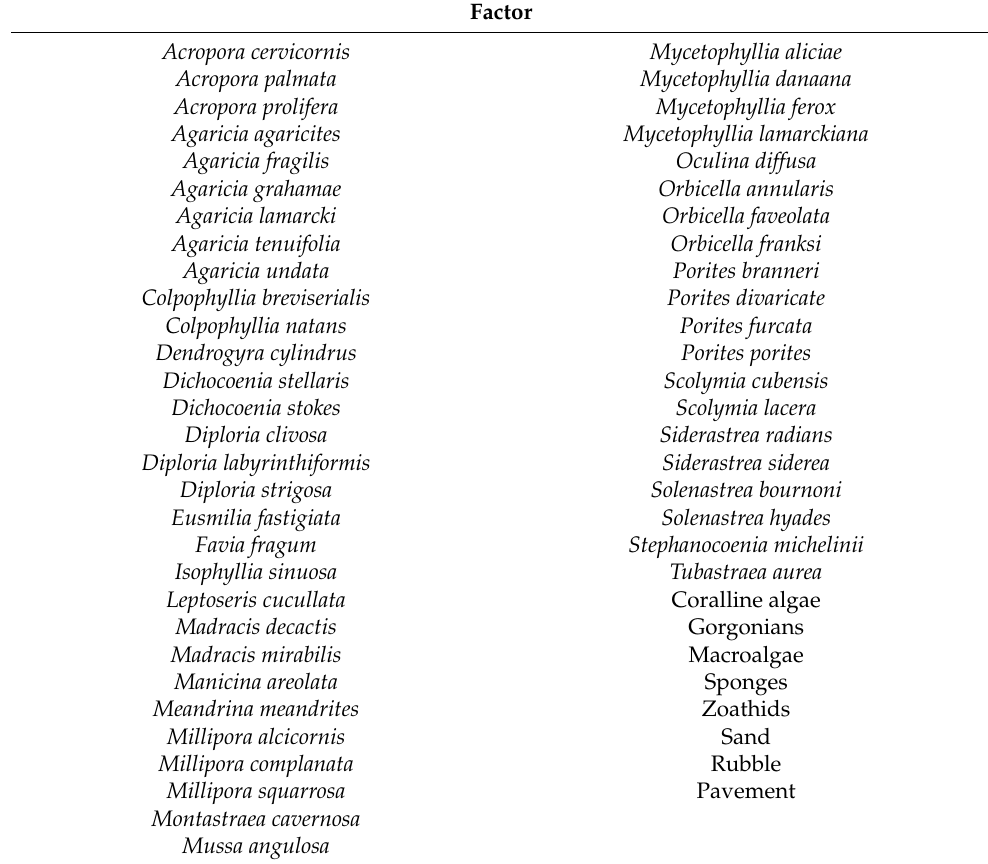
Table 2. Interspecific and substrate factors tested for inclusion in the correlation